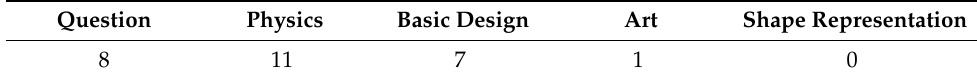
Table 9. Answers to the question about which link was the